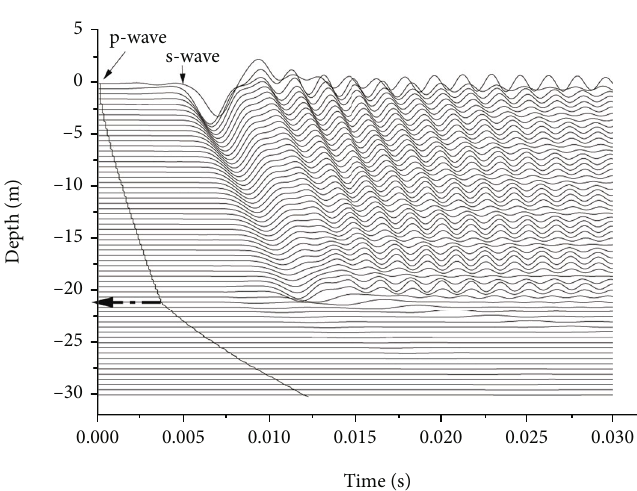
Figure 7: Waveform combination time-depth diagram.